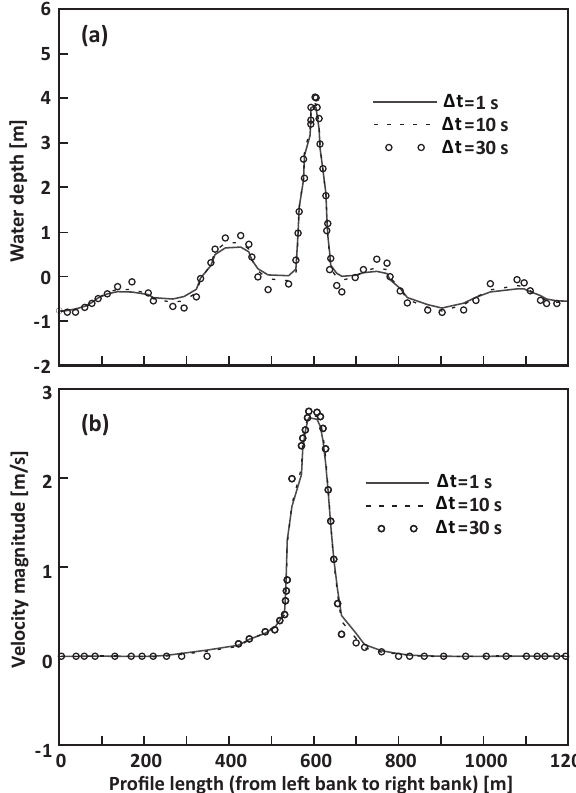
Figure 4. Results of time sensitivity